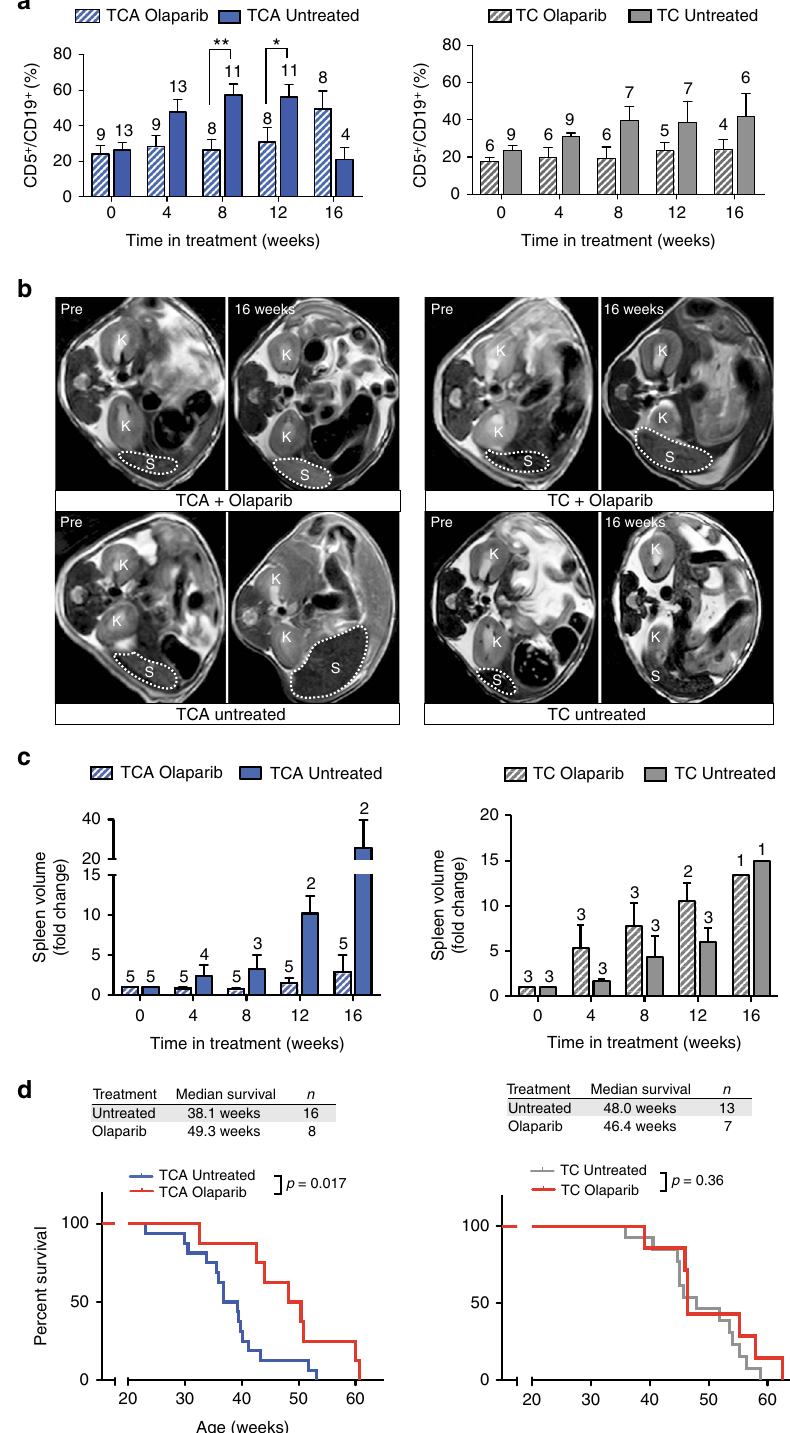
Fig. 5 Atm -de fi cient CLLs display an actionable dependence on PARP. ATM has been shown to regulate HR-mediated DNA DSB repair. To directly address a potential dependence of Atm -de fi cient CLLs on the PARP-dependent BER pathway, we treated leukemic TC and TCA animals with the PARP inhibitor olaparib (50 mg/kg, i.p., daily, 5 days/week) and monitored disease progression and overall survival. Control cohorts were left untreated. The CD5 + /CD19 + fractions of peripheral blood lymphocytes of olaparib-treated or untreated TCA and TC animals are illustrated in a . Numbers above bars indicate the number of mice that were alive at the time of imaging in each group. Lymphadenopathy was monitored through MR imaging in 8 week intervals. Representative images of mice scanned at day 0 and day 112 of treatment/observation are shown in b . The fold change of spleen volumes of olaparib-treated and untreated mice is illustrated in c . d Overall survival of TC and TCA mice treated with olaparib or left untreated. Error bars represent standard deviation. b , c Welch ’ s t -test, d log-rank test. * p < 0.05, ** p <